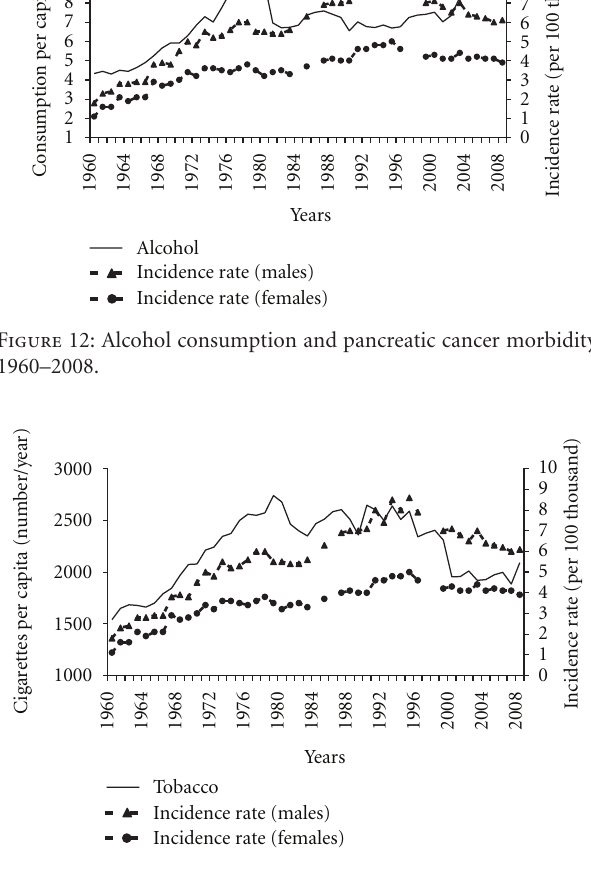
Figure 13: Tobacco smoking and pancreatic cancer morbidity